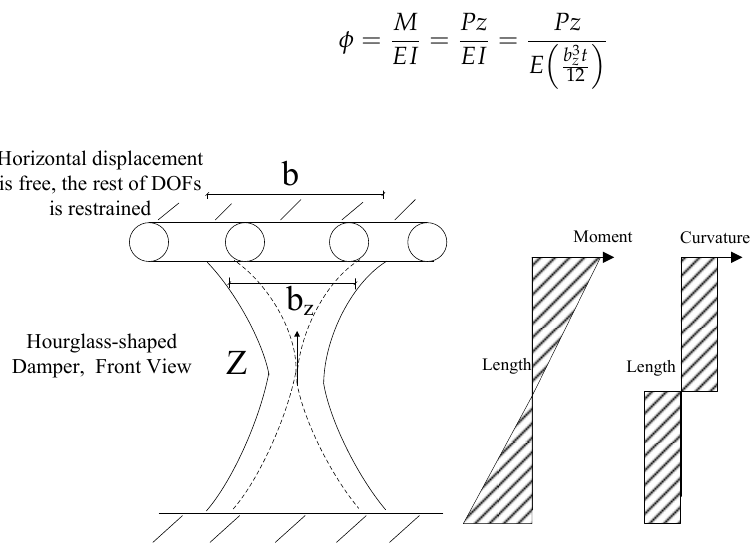
Figure 5. The geometry of the butterfly-shaped damper for constant curvature concept.